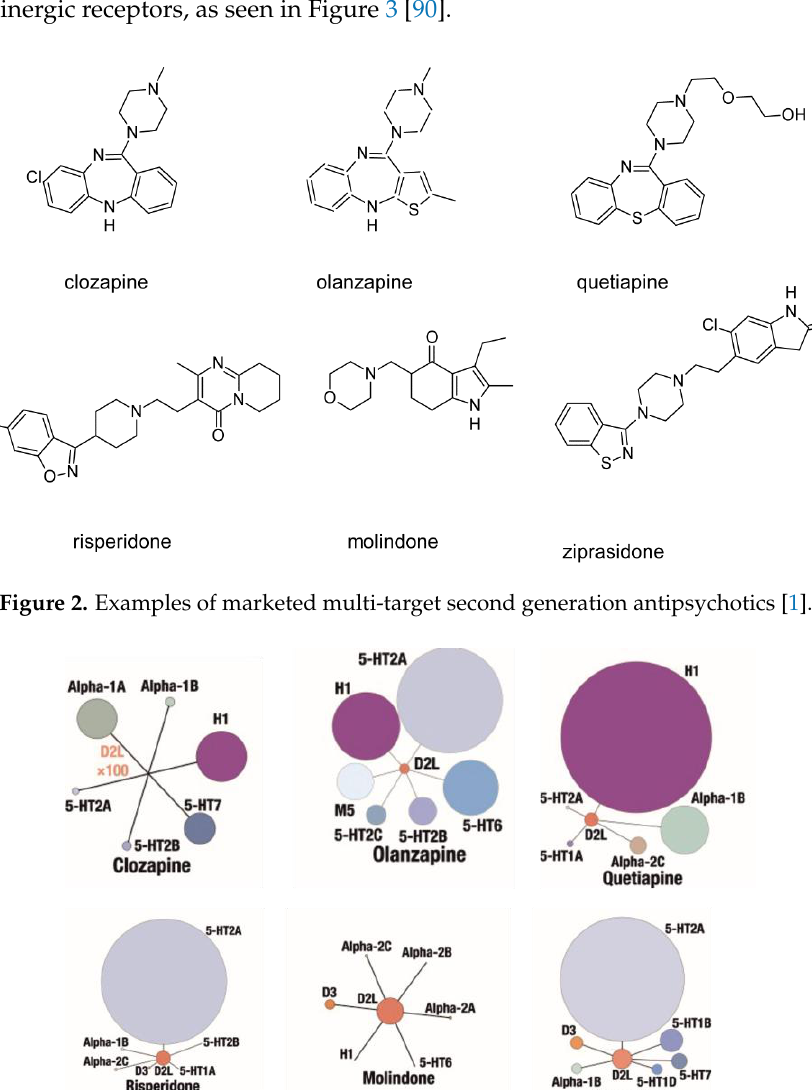
Figure 3. Pharmacological profiles of commonly used second generation antipsychotics,